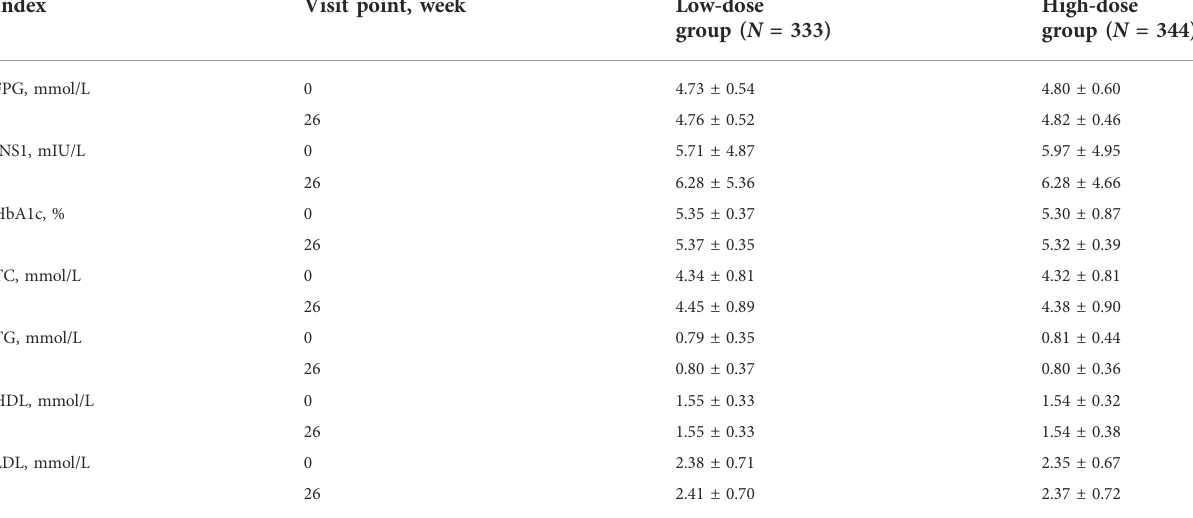
TABLE 2 Blood glucose and lipid indexes during PEG-rhGH treatment